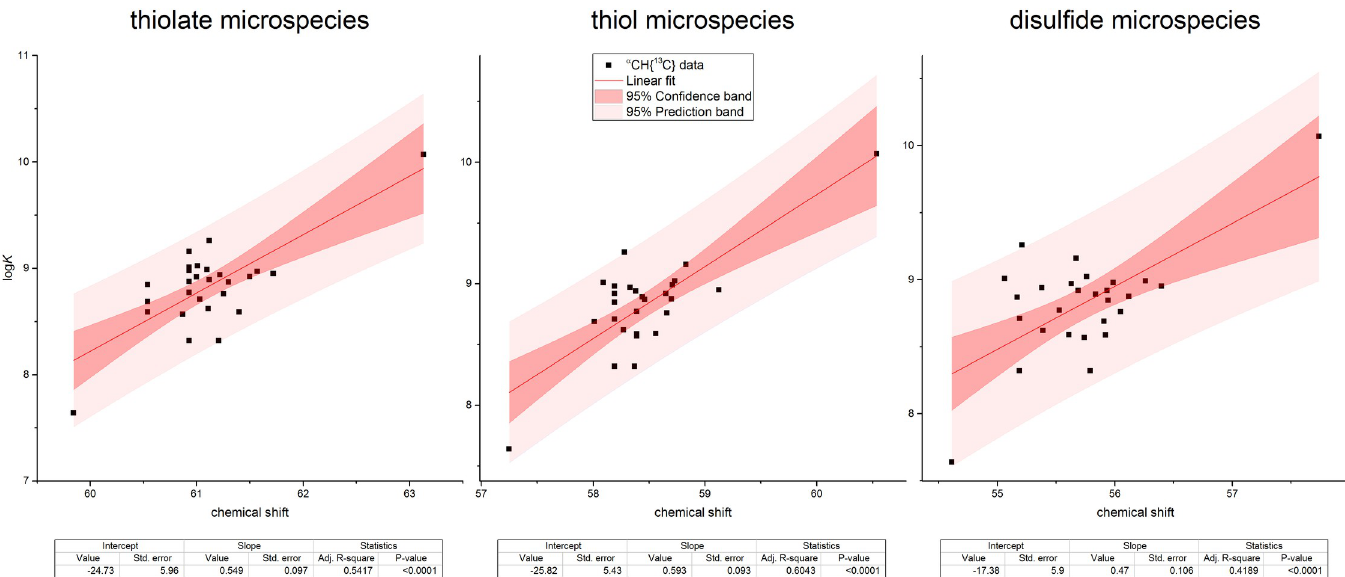
Fig 4. The univariate linear regression fits of the α CH 13 C data for all studied compounds together with 95% confidence and prediction bands.